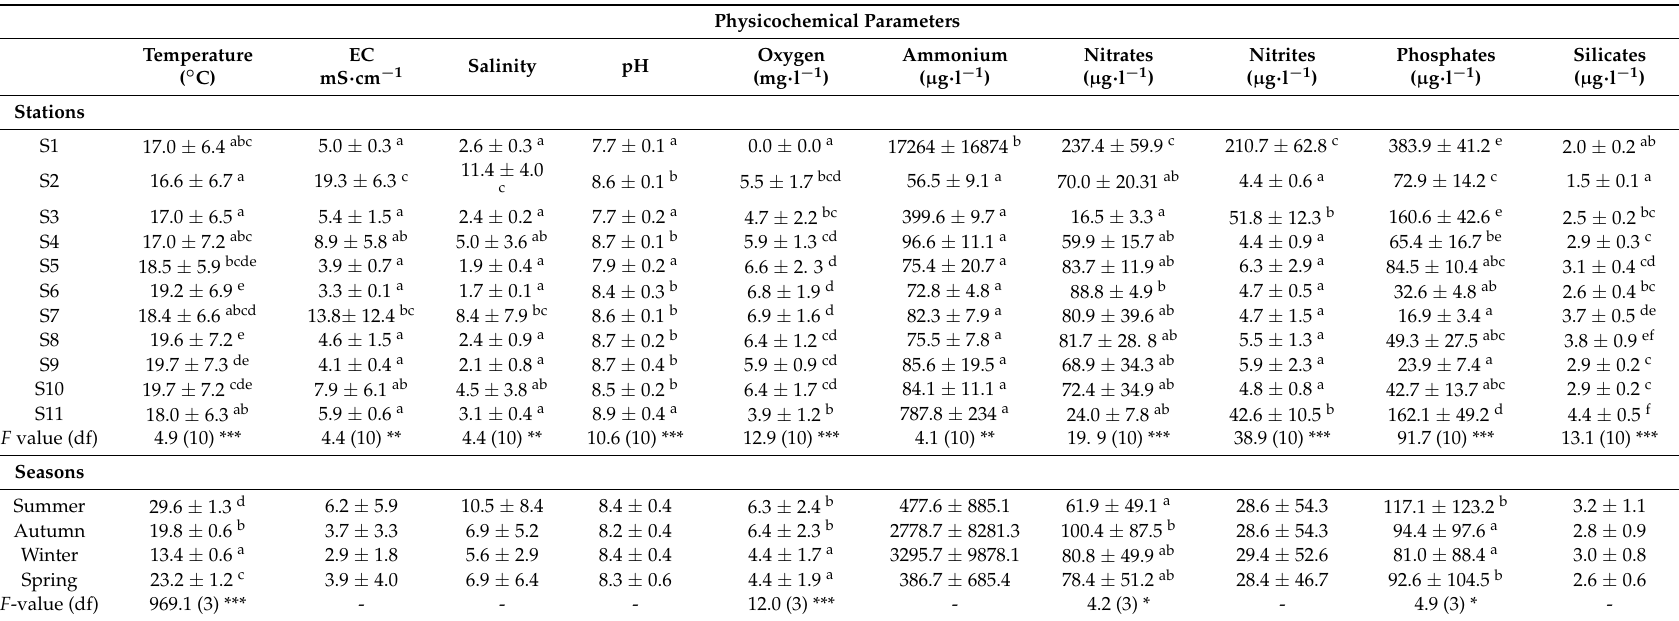
Table 1. Physicochemical parameters observed in Lake Manzalah. Annual mean ± SD at each station and seasonal mean ± SD in the whole lake are shown. F -values were determined by two-way ANOVA test, p -values for differences among stations and seasons within each parameter. Values in each line that share the same letter (a, b, c, d) are not significantly different ( p > 0.05). * p < 0.05, ** p < 0.01, *** p <